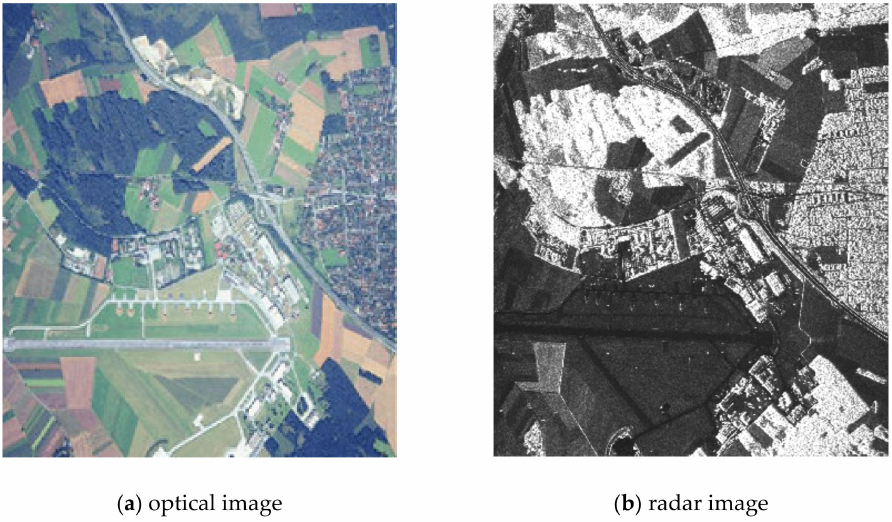
Figure 3. Optical and radar images of the same area.